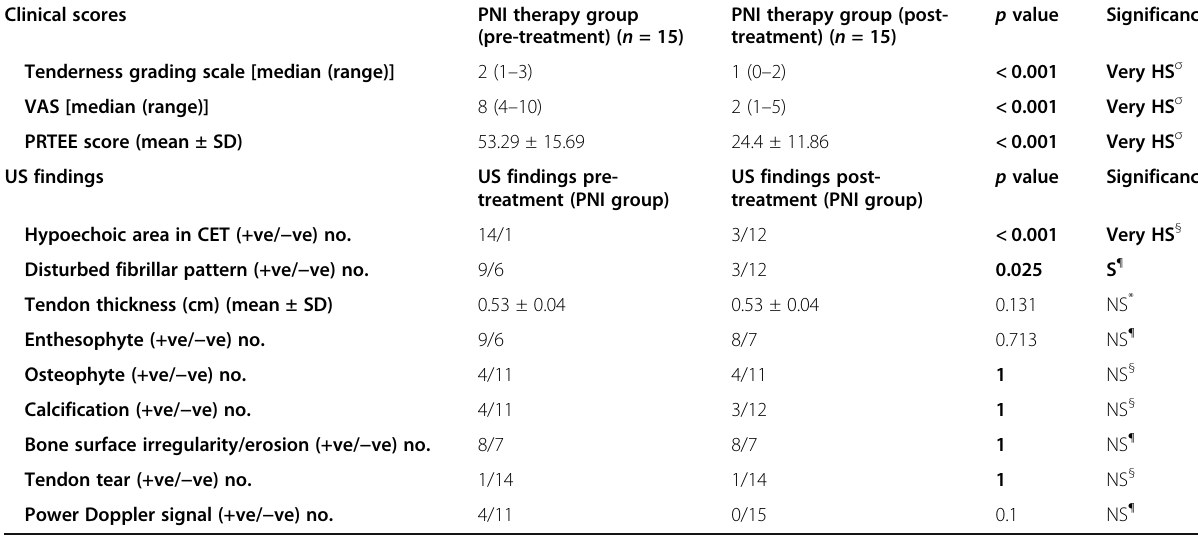
Table 3 Comparison of tenderness grading scale, pain intensity measured by VAS scale, PRTEE score, and US findings before and after treatment in PNI therapy group Clinical scores PNI therapy group (pre-treatment) ( n =